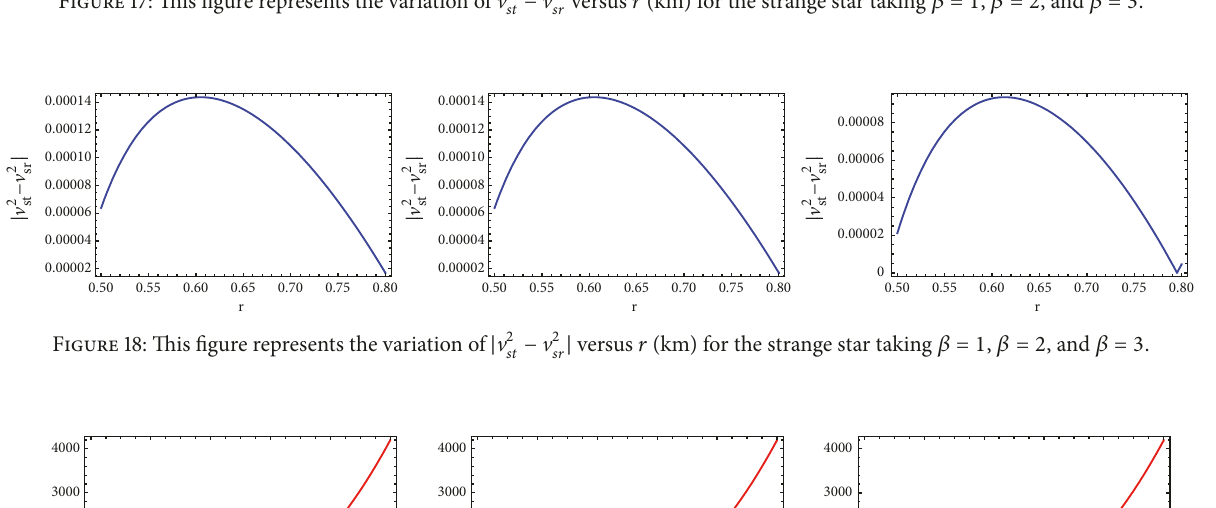
Figure 17: This figure represents the variation of V 2 𝑠𝑡 − V 2 𝑠𝑟 versus 𝑟 (km) for the strange star taking 𝛽 = 1 , 𝛽 = 2 , and 𝛽 = 3 .